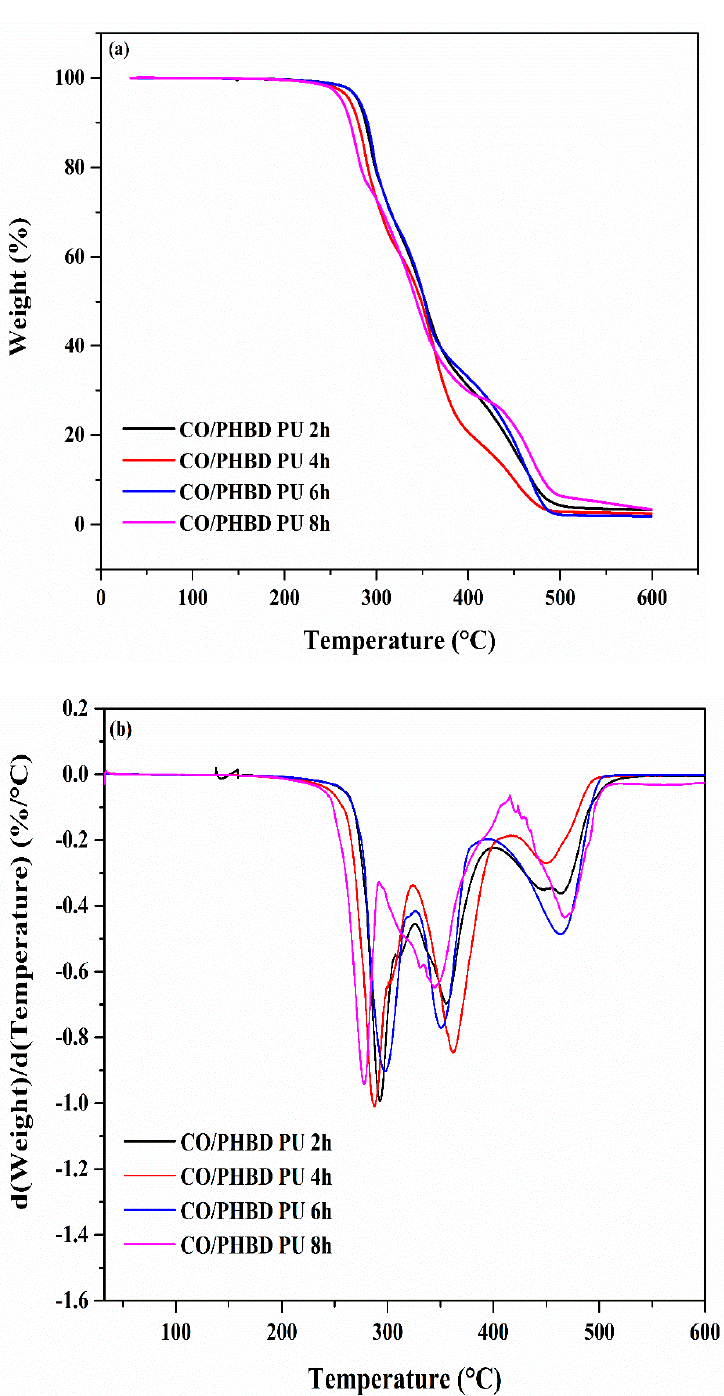
Figure 9. ( a ) TGA and ( b ) derivative TGA curves of CO/PHBD PUs.